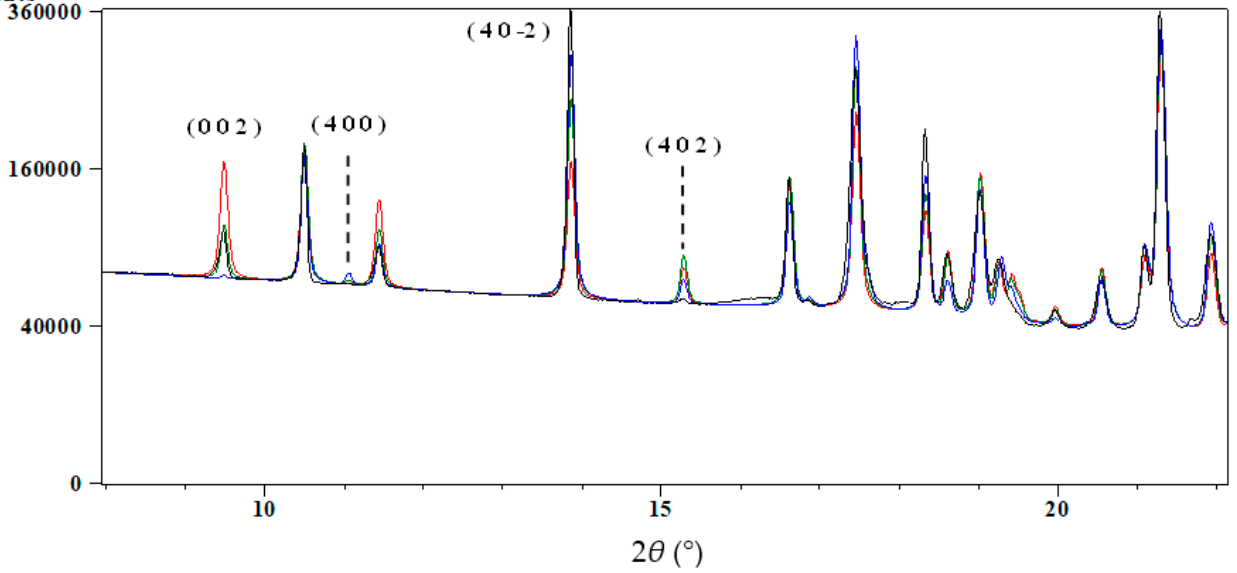
Figure 5. Comparison between XRPD diffractograms of the experimental bulk powder (black) and the calculated powder XRD profiles from Rietveld refinements (structure models before optimization (blue), after DFT-D geometry optimization: step 11 (green) and step 30 (red)). Only enlargement from 8 to 22° 2 θ is represented. Most relevant diffraction peaks (hkl) are identified.